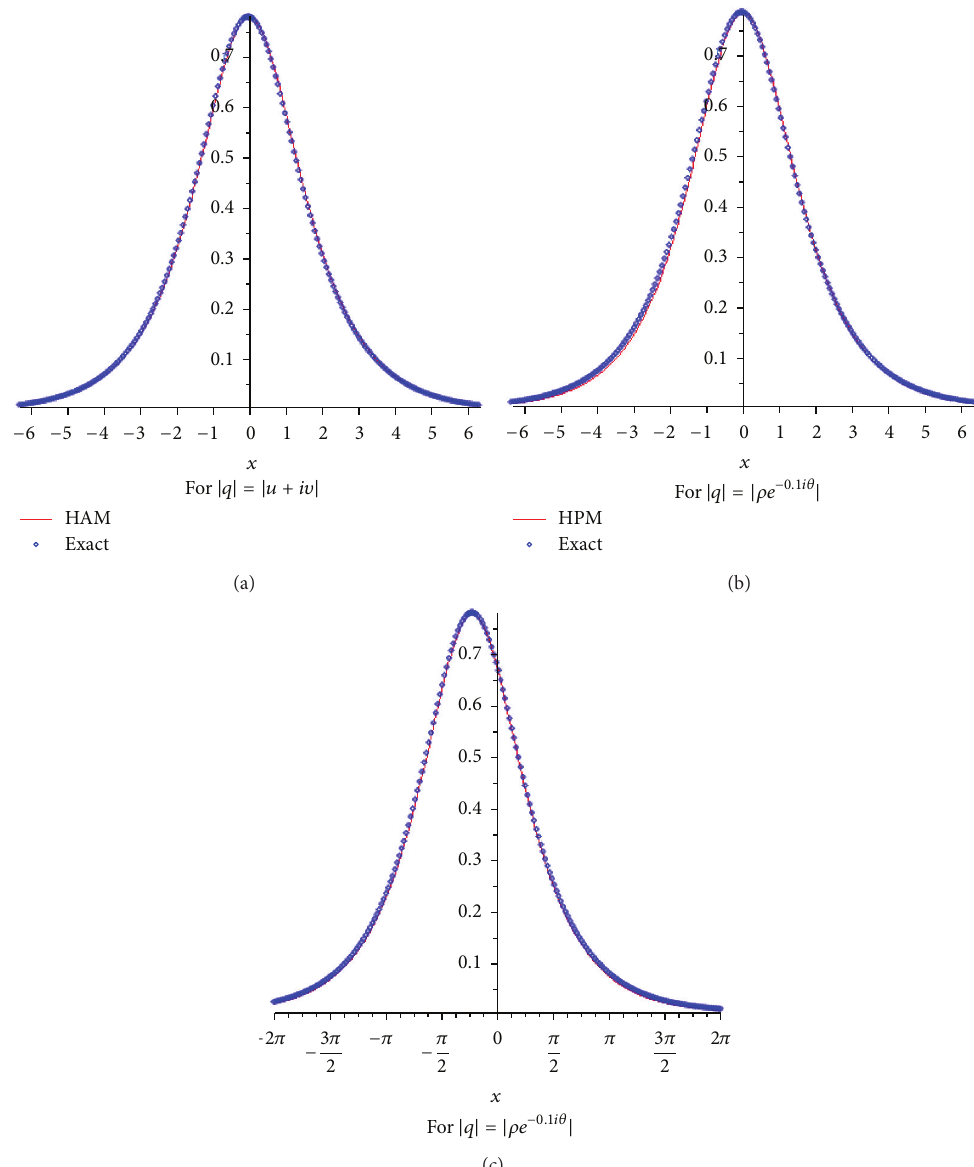
Figure 3: The results obtained by HPM and HAM for 𝑞(𝑥,𝑦, 𝑡) , at 𝑡 = 0.2 in comparison with the exact solutions.